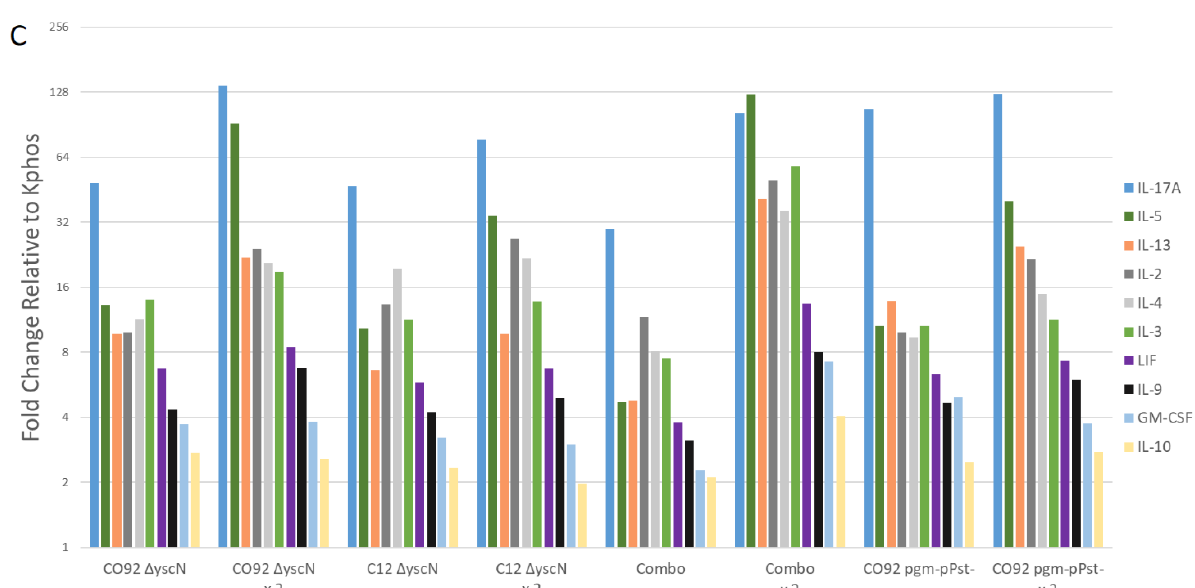
Figure 1. Splenocytes were harvested and re-stimulated for cytokine/chemokine expression with ( A ) F1-V fusion protein vaccine, ( B ) γ -radiation inactivated Y. pestis CO92, or ( C ) γ -radiation inactivated Y. pestis C12 (nonencapsulated) bacteria and the supernatants were evaluated for cytokine expression by Luminex ( n = 5 for each group). The fold changes in cytokines/chemokines in splenocytes were determined by dividing the geometric mean of log-transformed data (pg/mL) of the cytokine/chemokine by that of the negative control (Kphos) within each group of vaccinated mice. Of note, the antigen used to stimulate the splenocytes resulted in differential cytokine expression profiles (e.g., IFN- γ was significantly upregulated by the addition of the F1-V immunogen but was not significantly upregulated by either killed whole cell antigen relative to naïve mice). Due to the less defined whole bacterial cell immunogens and their impacts on splenocytes harvested from naïve mice, the fold change data normalize the immune responses elicited by the F1-V recombinant protein compared to γ -irradiated Y. pestis cells. The Y-axis (fold change relative to Kphos) scale is different in each graph.